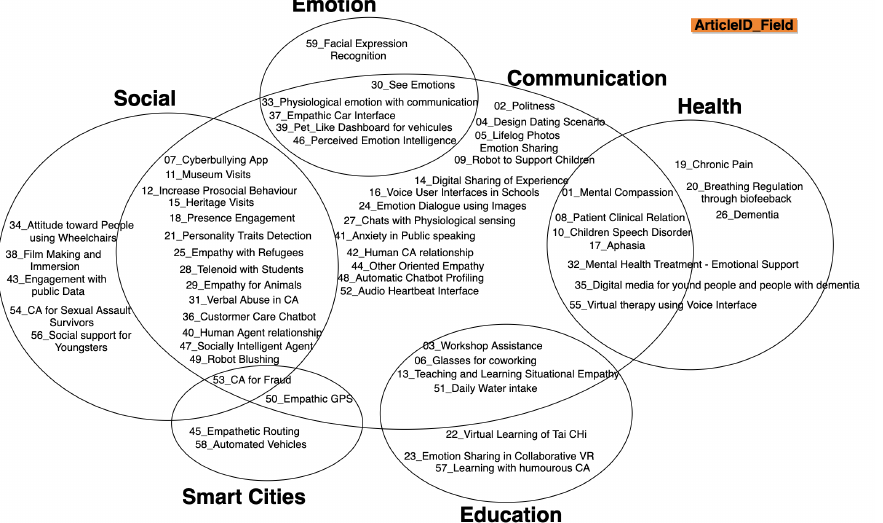
Figure 9. Distribution of articles over the fields of